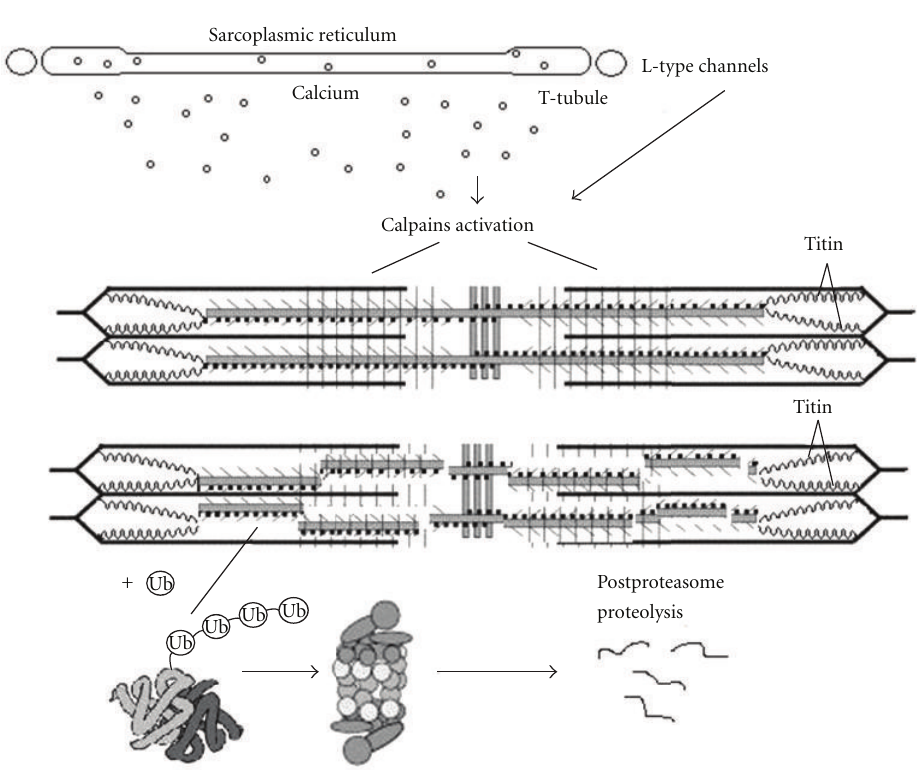
Figure 1: Interaction between proteolytic systems in mammals skeletal muscles under disuse atrophy. Preliminary disorganization of my- ofibrils by calpains helps to degrade myofibril proteins by UPS. Ca 2+ accumulation can activate calpains localized near Z-disk. Main calpains target is titin, whose cleavage leads to E3-ubiquitin ligases